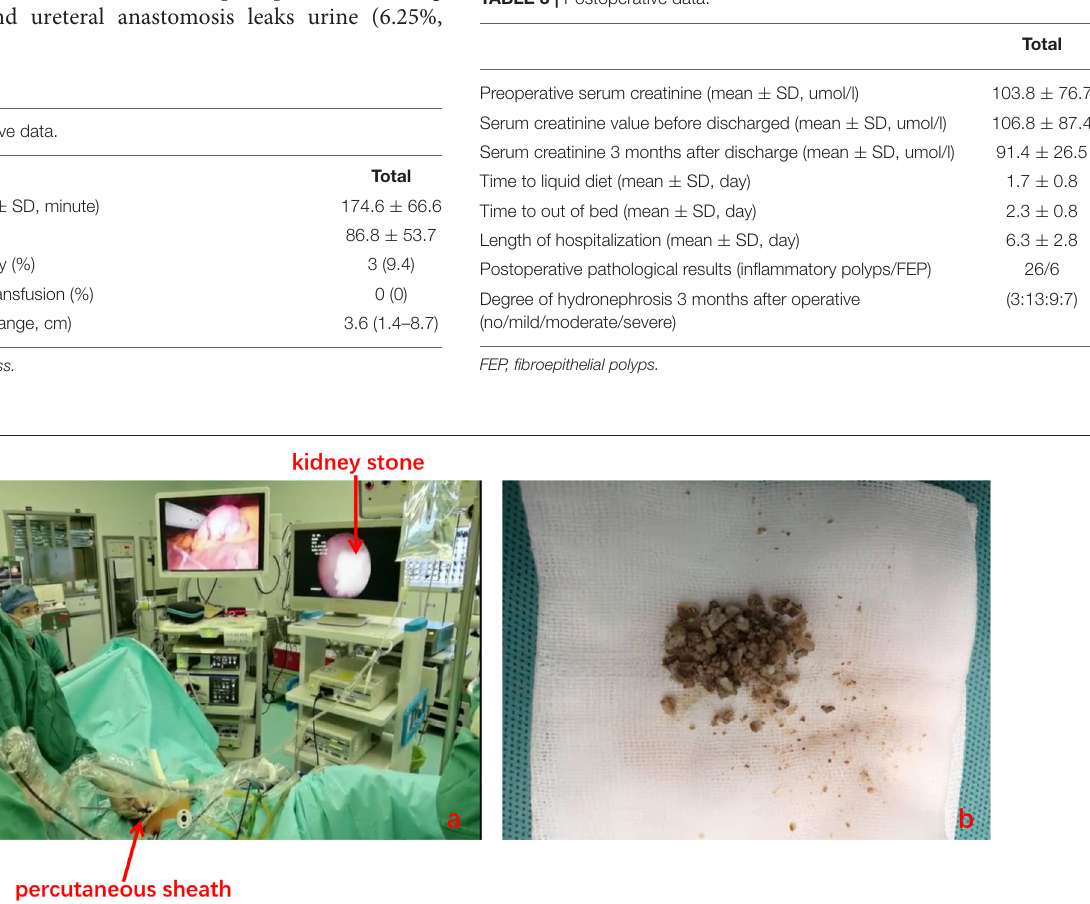
TABLE 3 | Postoperative data.